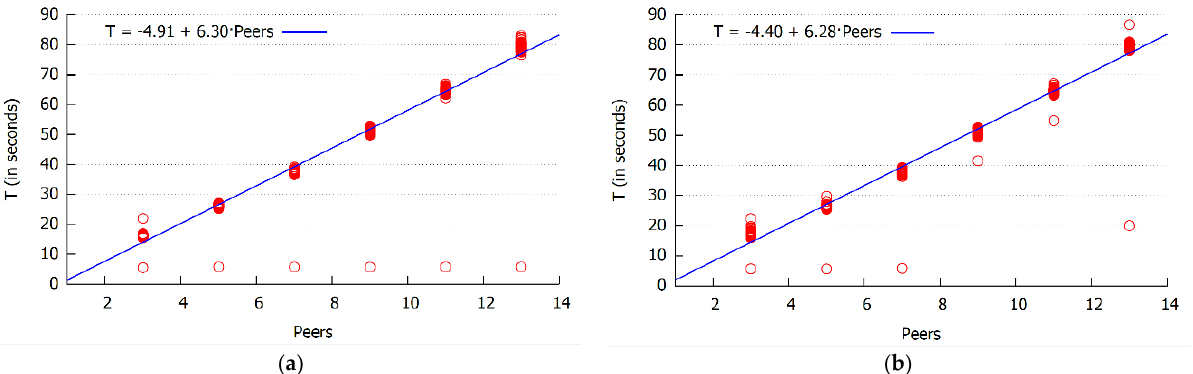
Figure 9. Model inference runtime (in seconds) in relation to the network size for the largest variant of the synthetic dataset: Chaincode ( a ) and oracle service ( b ) results. The linear relationship is evident where an additional peer in the network increases runtime T by 6.3 s for the chaincode and 6.28 s for the oracle service.